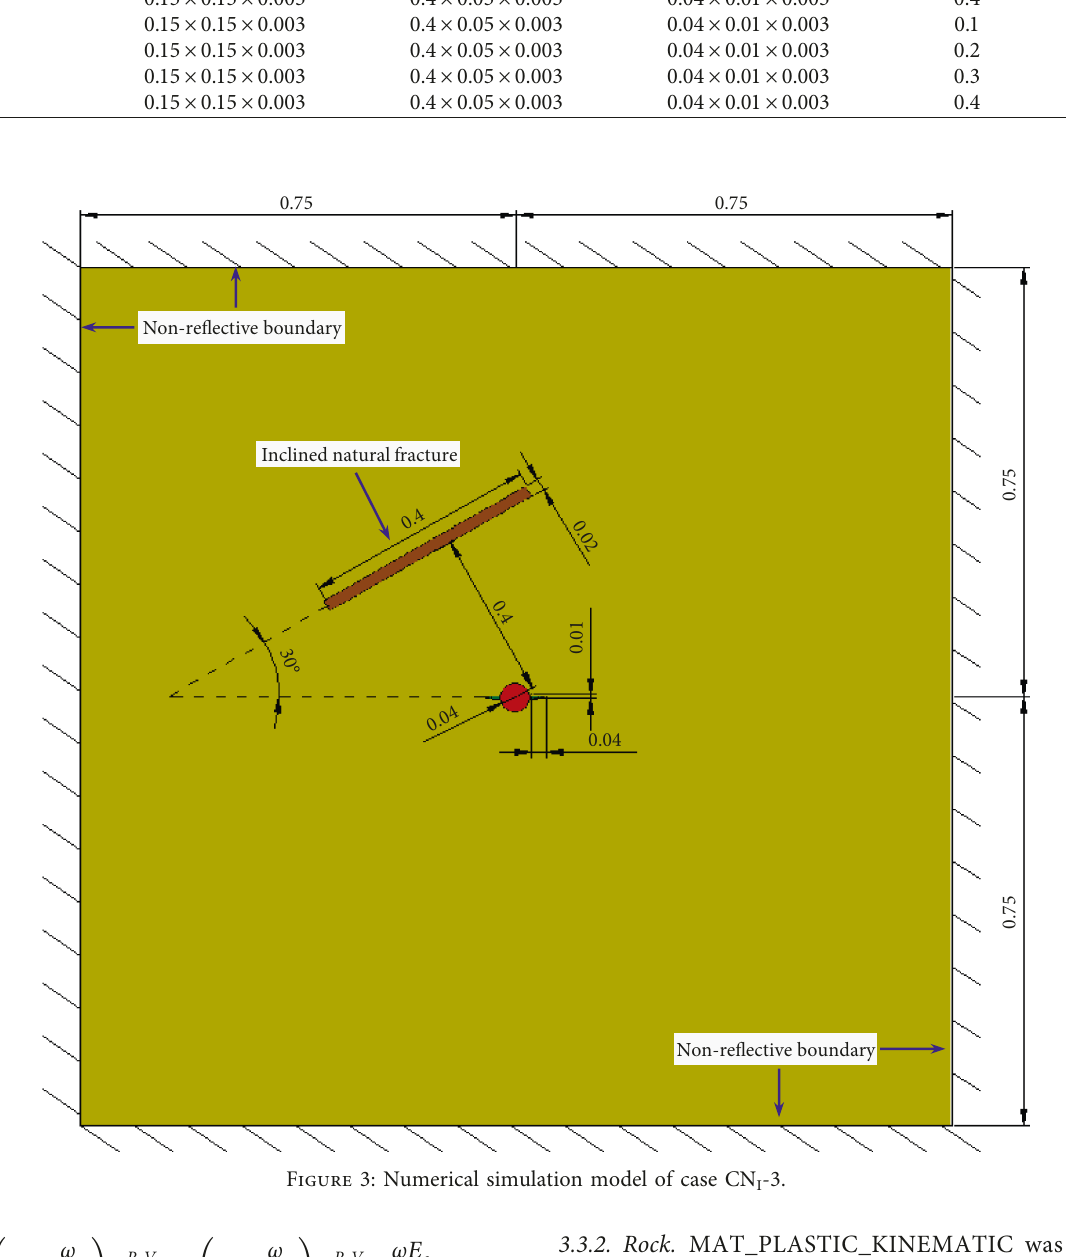
Figure 3: Numerical simulation model of case CN